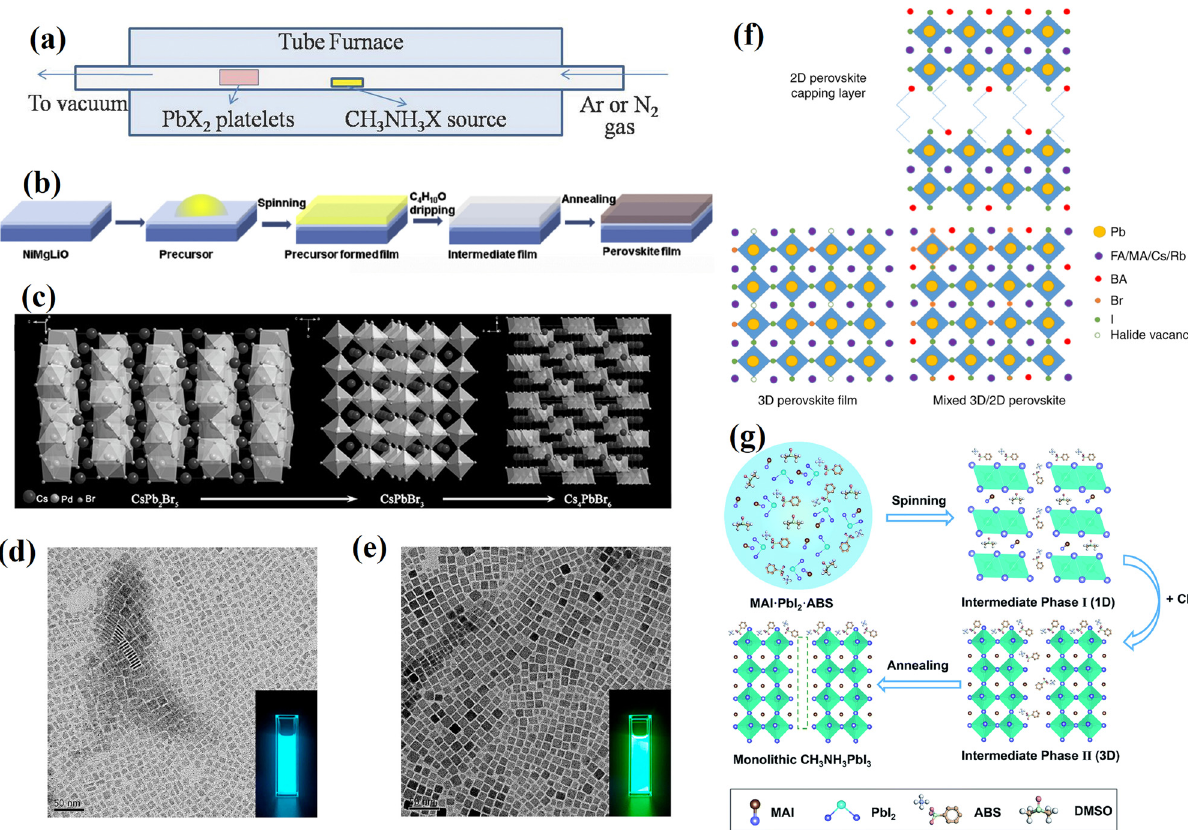
Figure 3: ( a ) The schematic of the synthesis setup for 2D perovskite nanoplate using a home - built vapor - transport system, reproduced with permission from ref. [ 53 ] . Copyright 2014, Wiley - VCH. ( b ) The solvent engineering procedure for preparing the uniform and dense inorganic CsPbI 2 Br perovskite fi lm, reproduced with permission from ref. [ 55 ] . Copyright 2018, Elsevier. ( c ) A clear crystal structure transformation in the synthesis process of the all - inorganic cesium lead bromide halide, reproduced with permission from ref. [ 57 ] . Copyright 2018, Wiley